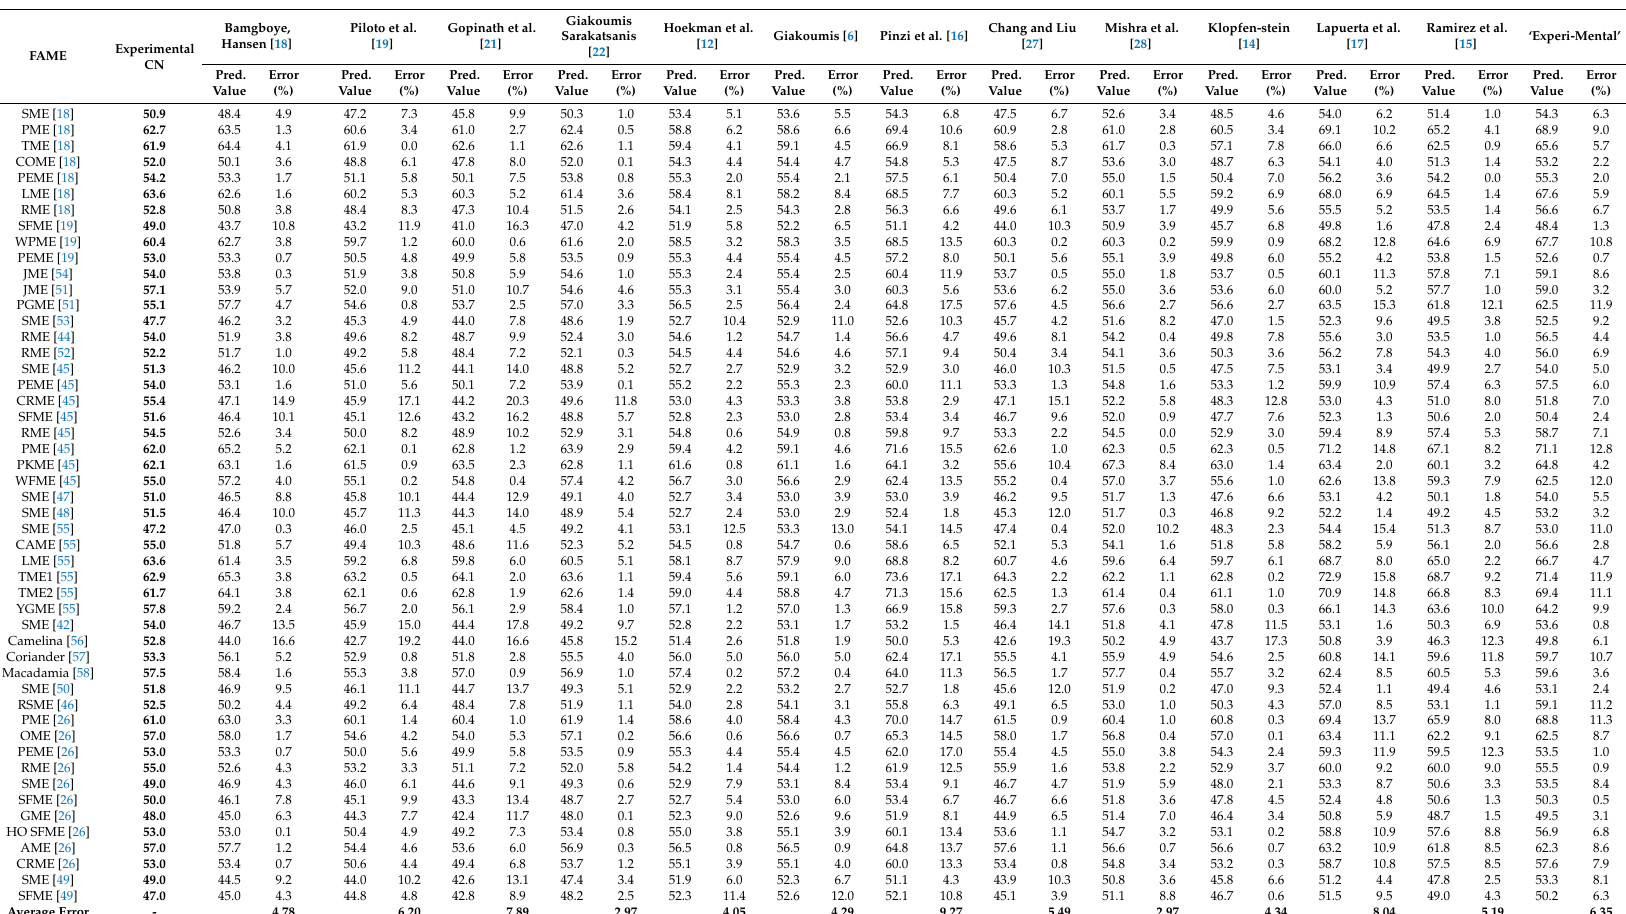
Table 5. Comparison between experimental and computed CN values, and absolute errors for all